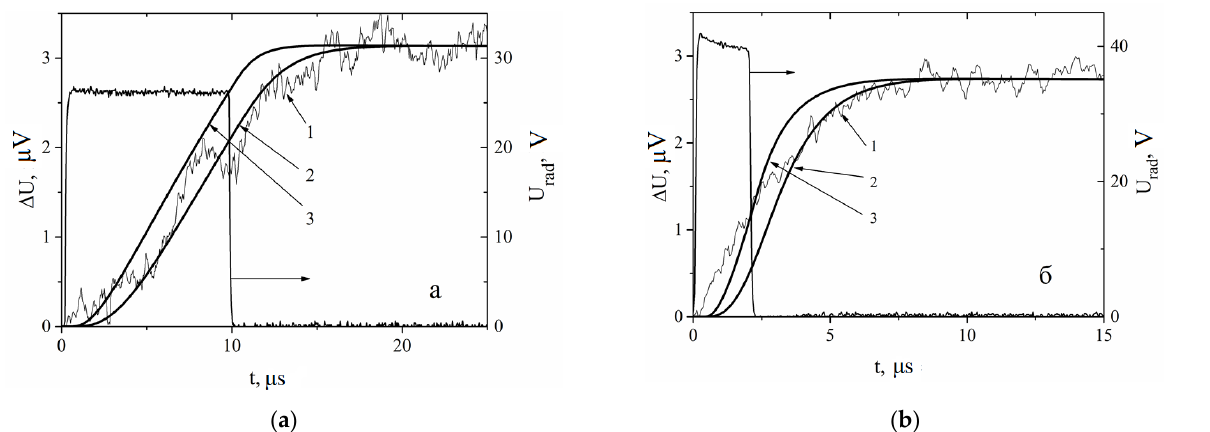
Figure 15. Detector response to pulses applied to BB source: ( a ) U rad = 26 V, 10 μ s; ( b ) U rad = 40 V 2 μ s. Curve 1: measured detector response. Curve 2: calculated response taking into account dependencies of P rad (t) and registration time τ = 1.8 μ s with τ det = 0. Curve 3: calculation taking into account detector response time τ det = 1.8 μ s ( a ) and τ det = 0.8 μ s ( b ), see also [12] (Reprinted with permission, Copyright 2018 Pleiades Publishing, Ltd.) .